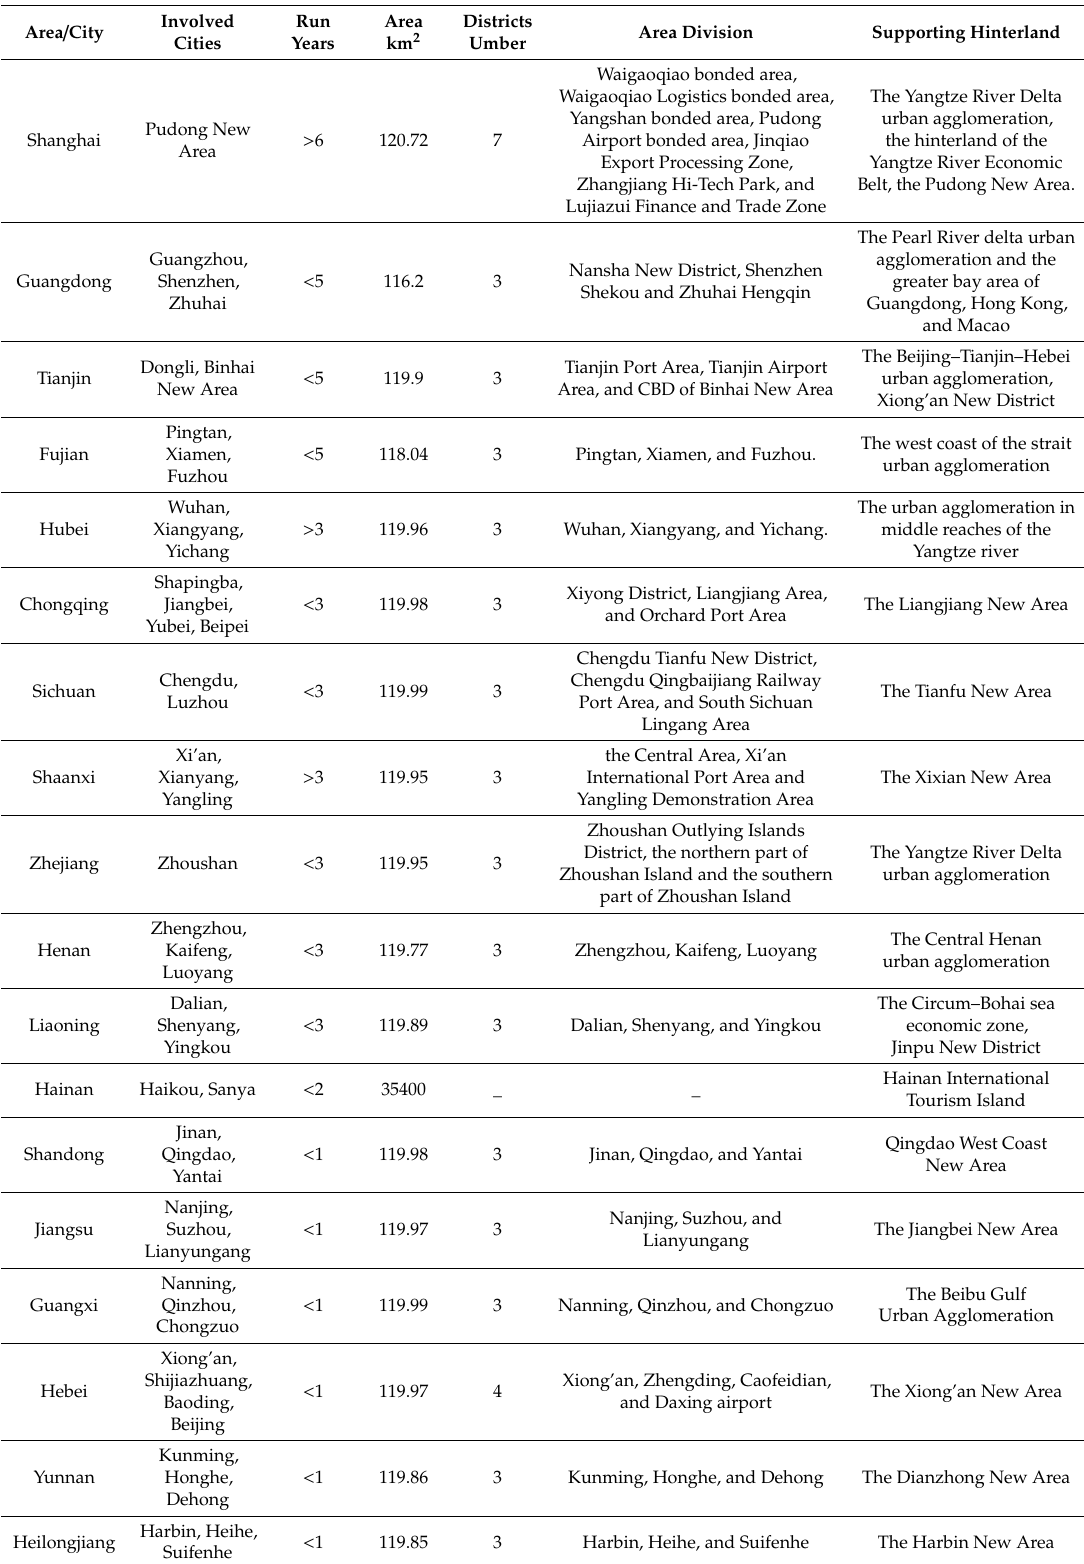
Table 1. Constructing factors of 18 free trade zones in